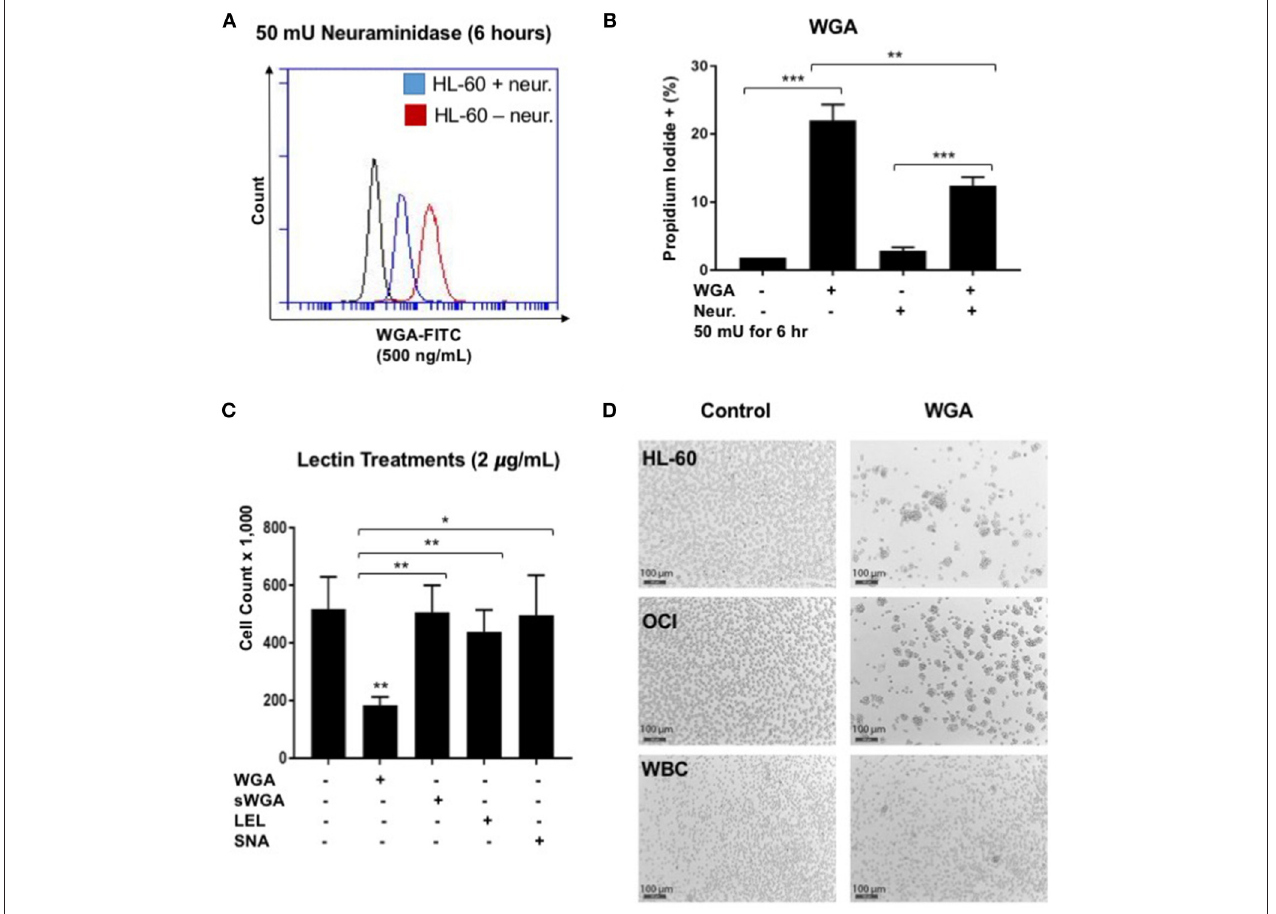
FIGURE 4 | WGA effect on AML is sialic acid dependent. (A) HL-60 cells treated with WGA-FITC (500ng/mL) to analyze WGA binding using flow cytometry. Cells untreated with neuraminidase (red peak) were overlaid with cells treated with neuraminidase (50 mU/mL) for 6h. (B) Percentage Propidium iodide positive HL-60 cells treated with WGA (4 µ g/mL) for 4h were analyzed with flow cytometry. HL-60 cells were either untreated or pre-treated with neuraminidase (50 mU/mL) for 2h. (C) Viable cell count of OCI-AML3 cells treated with 2 µ g/mL WGA, sWGA, LEL, and SNA for 24h counted using trypan blue. (D) HL-60, OCI, and healthy human white blood cells (WBCs) treated with either 2 µ g/mL WGA or with 2 µ L PBS as a negative control and after 20h treatment, cells were assessed at 10 × magnification using bright field microscopy. Scale bar 100 µ m shown. * p < 0.05, ** p < 0.01, *** p < 0.001, and ns >